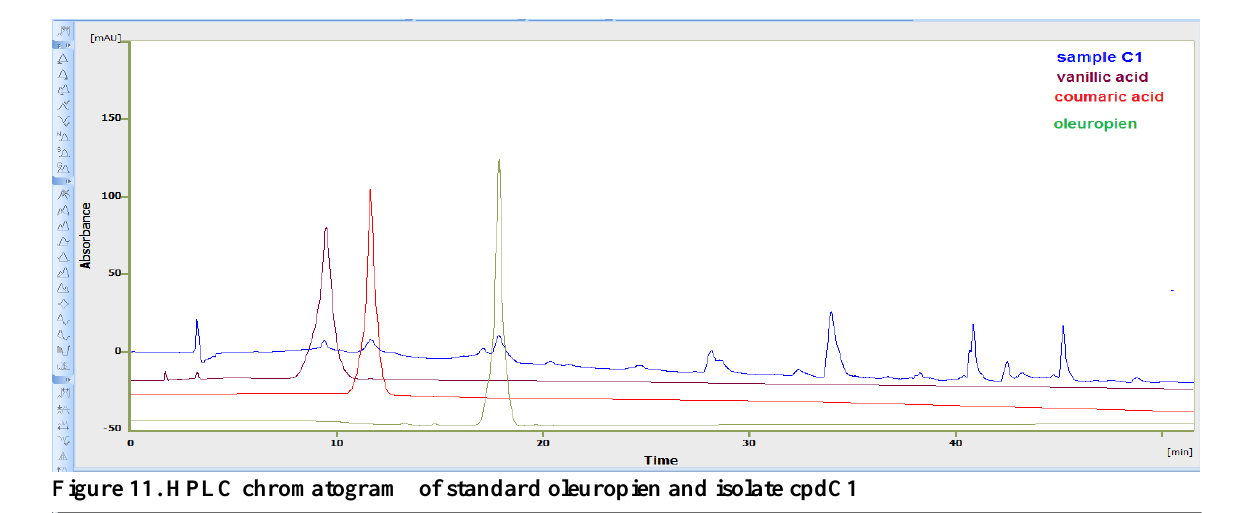
Figure 11. HPLC chromatograme of standard oleuropien and isolate cpdC1